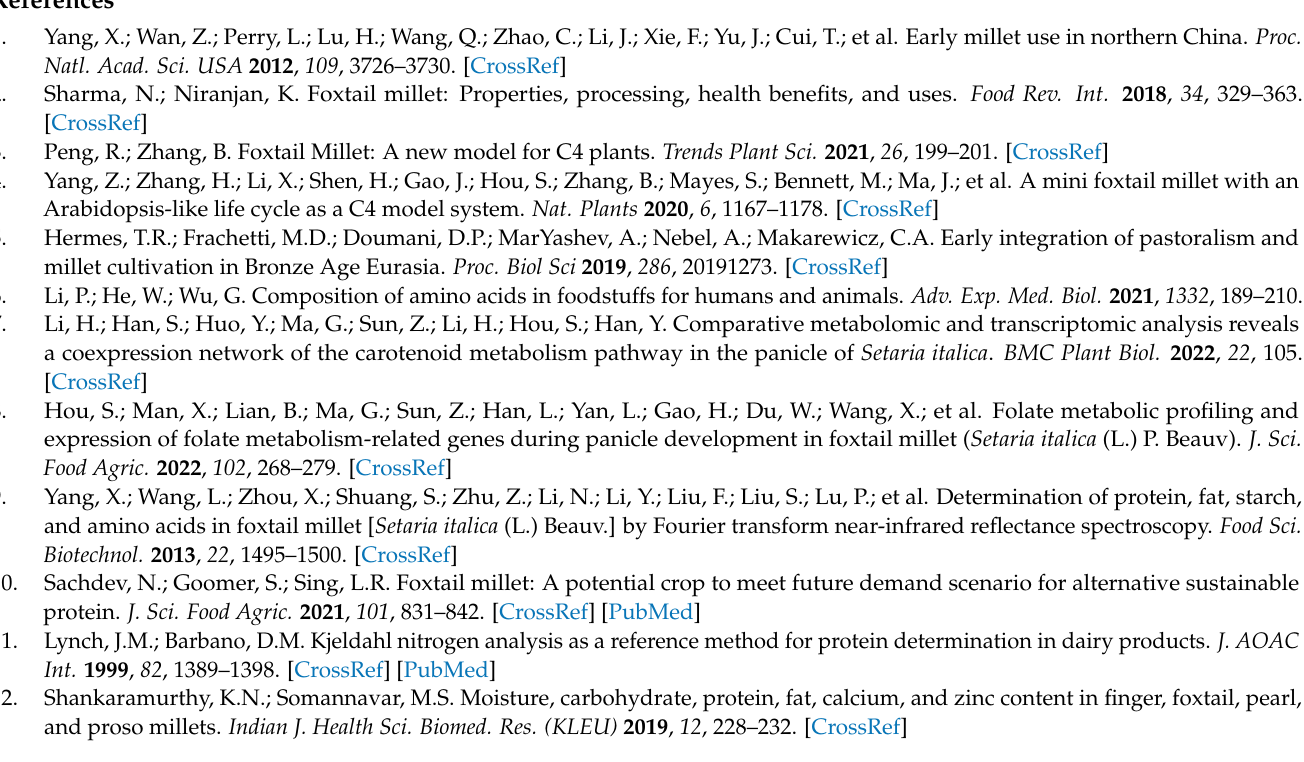
Table S2: The soil conditions in three plant environments, Table S3: EAA content in WHO, FAO, UNU models (mg/g pro), Table S4: Ten foxtail millet varieties with relatively stable protein content (%) in three environments, Table S5: AAS (%) of ten foxtail millet varieties in the E1, Table S6: AAS (%) of ten foxtail millet varieties in the E2, Table S7: AAS (%) of ten foxtail millet varieties in the E3, Table S8: EAAI values of 10 foxtail millet varieties in E1 area, Table S9: EAAI values of ten foxtail millet varieties in E2 area, Table S10: EAAI values of ten foxtail millet varieties in E3 area, Table S11: Total starch content (g · 100 g − 1 ) of 10 varieties of foxtail millet in 2018, Table S12: The grain hardness index (N) of 10 varieties of foxtail millet in 2018, Table S13: Gel consistency (mm) of 10 varieties of foxtail millet in 2018, Table S14: Grain color index (b value) of 10 varieties of foxtail millet in 2018, Table S15: Brightness (L value) of 10 varieties of foxtail millet in 2018, Table S16: The subordinative function analyzed for eating quality-traits among the varieties of foxtail